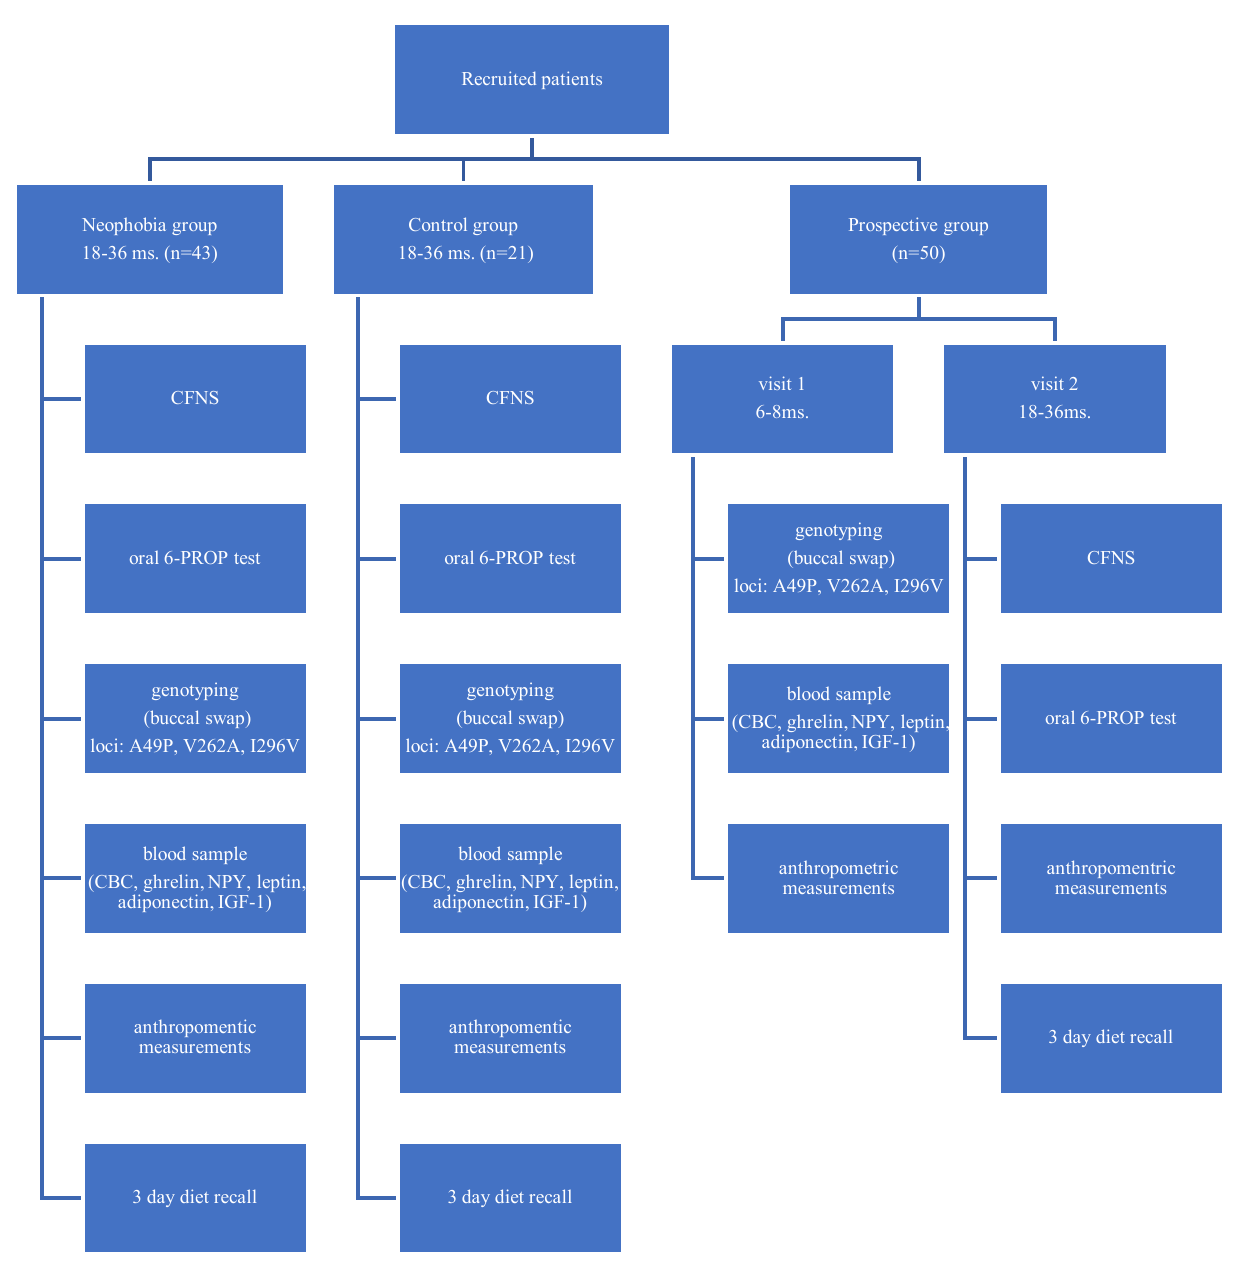
Figure 2. Flowchart of study design. CBC = complete blood count, 6-PROP = 6-propylthiouracil, CFNS = the child food neophobia scale, NPY = neuropeptide Y, IGF-1 = insulin-like growth factor.